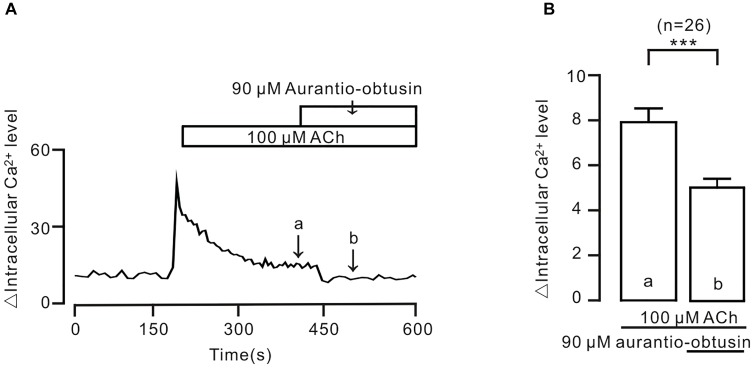
Aurantio-obtusin inhibits ACh-induced Ca2+ increases in single tracheal smooth muscle cells. (A) ACh induced a transient and a sustained increase of intracellular Ca2+. The latter was inhibited following the addition of aurantio-obtusin. The values at the sites indicated by a and b were obtained. (B) Summary results from 26 cells. ∗∗∗P < 0.001. These results indicate that aurantio-obtusin inhibits increased Ca2+.